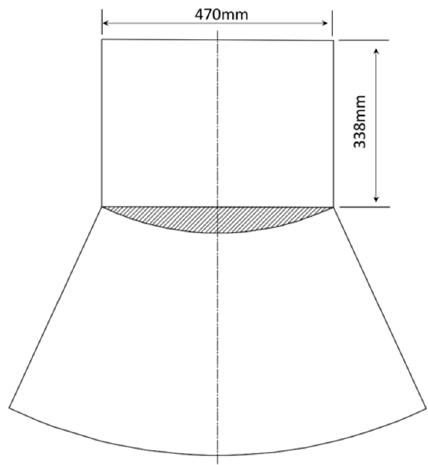
Figure 5. Unfold drawing of the target workpiece. The shaded area denotes a gap.